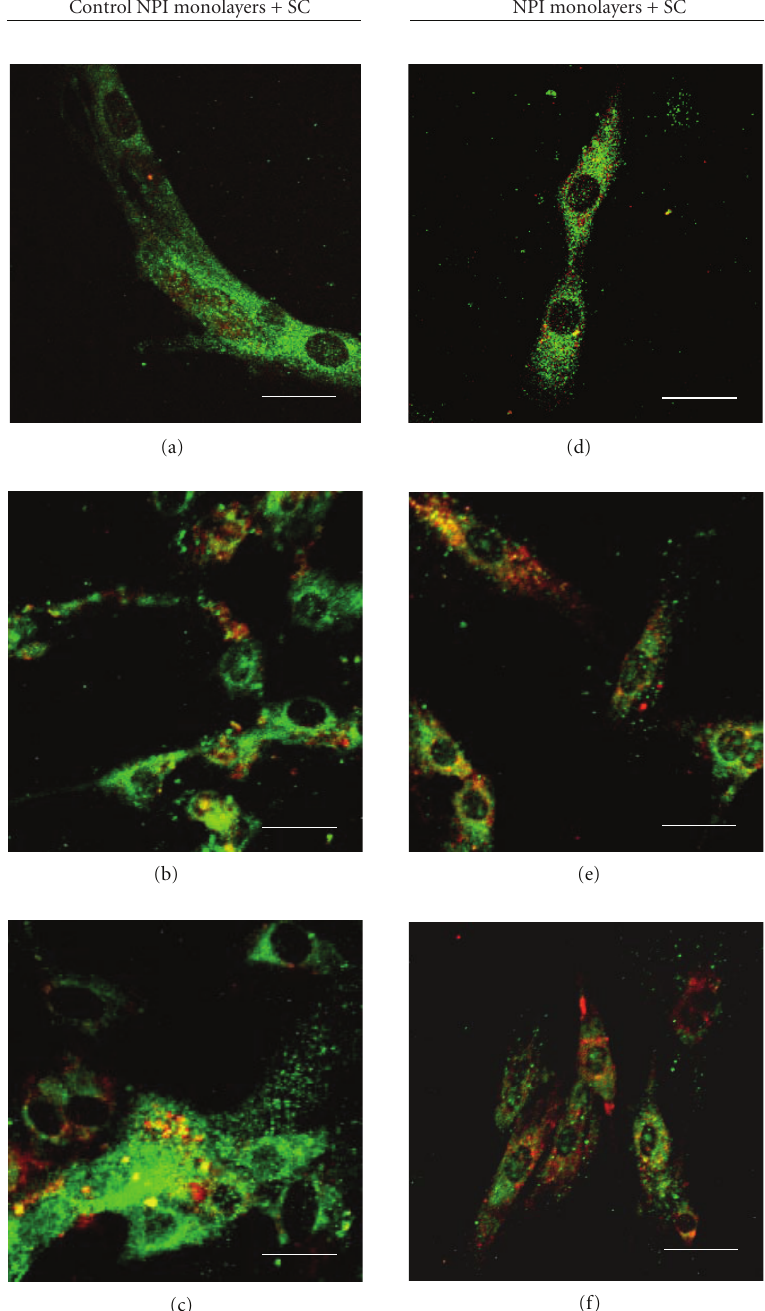
Figure 6: Double fluorescence immunolabeling (green signal: anti-PDX-1 Ab; red signal anti-c-kit Ab) under confocal laser microscopy of NPI cell monolayers cultivated for 7 (a), (d), 14 (b), (e), and 21 (c), (f) days, alone (a)–(c) or with SC (d)–(f). Bar = 10 μ m.